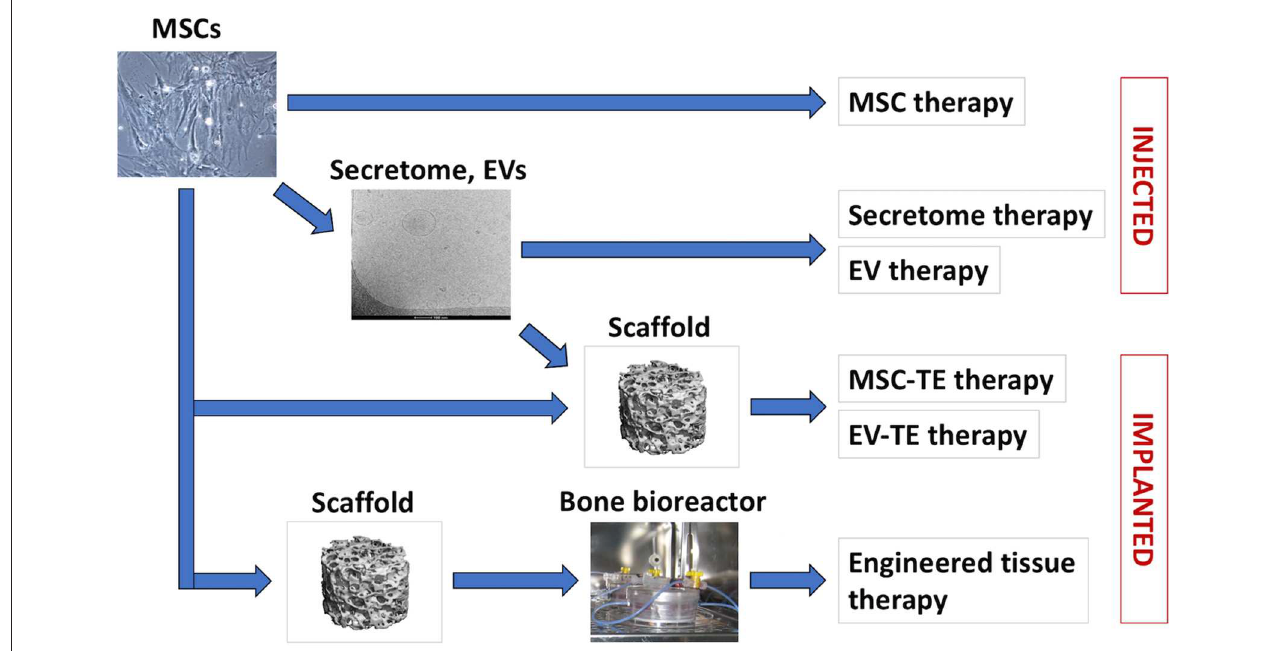
FIGURE 1 | MSC-based bone regeneration strategies. Cultured MSCs can be used for cell therapies or for therapeutic secretome/EVs production (arrow). In tissue engineering (TE) therapies, MSCs or MSC-EVs are applied in combination with biomaterial scaffolds. For certain indications, MSCs are seeded on biomaterial scaffolds and cultured in vitro in bioreactors, to support engineered tissue development and maturation prior to